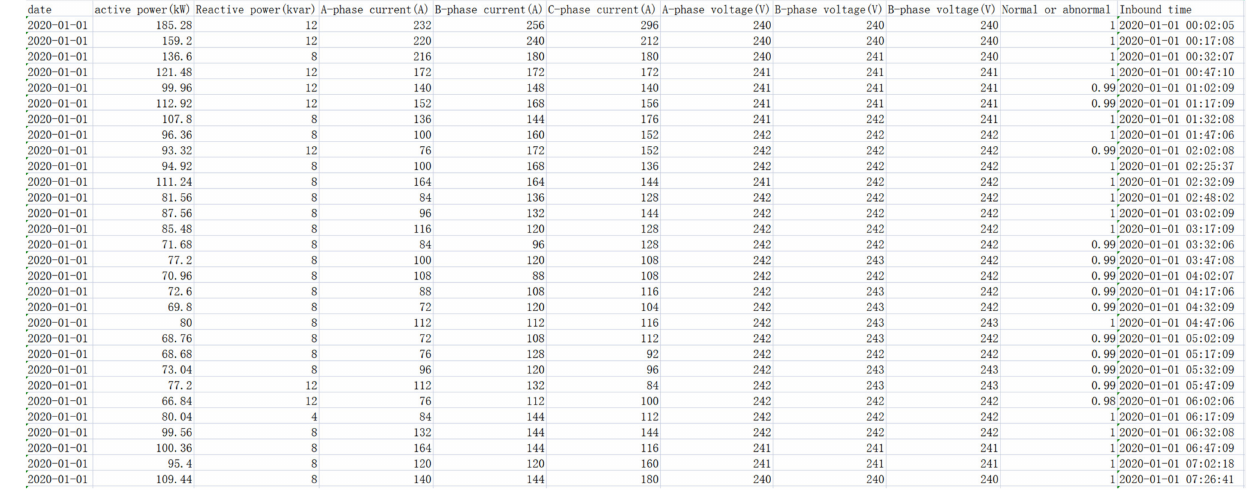
Figure 7. Partial screenshots of real data sets.